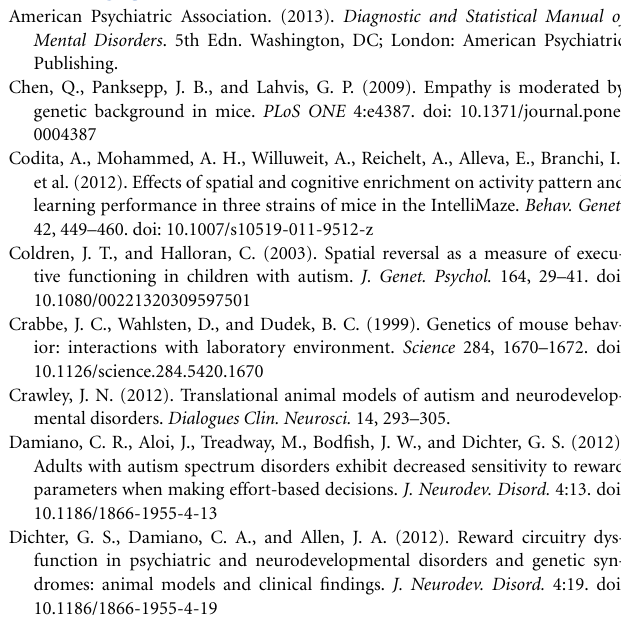
groups: C57BL/6 or BALB/c control vs. valproate-treated mice). Figure S5 | Hippocampal long-term potentiation (LTP) level corresponds to place preference learning efficiency in C57BL/6 and BALB/c strains.